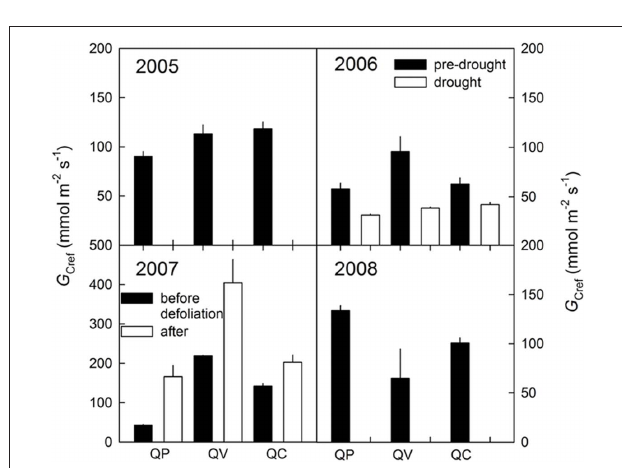
Figure 5 | reference canopy stomatal conductance ( G non-limiting light conditions for all years investigated (2005–2008). In 2006, the black bars denote before, the white bars during drought and in 2007, the black bars denote before, and the white bars after the defoliation event. QP, Quercus prinus ; QV, Q. velutina ; QC, Q.